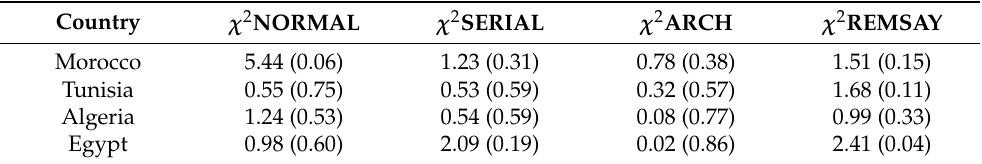
Table 7. Diagnostic